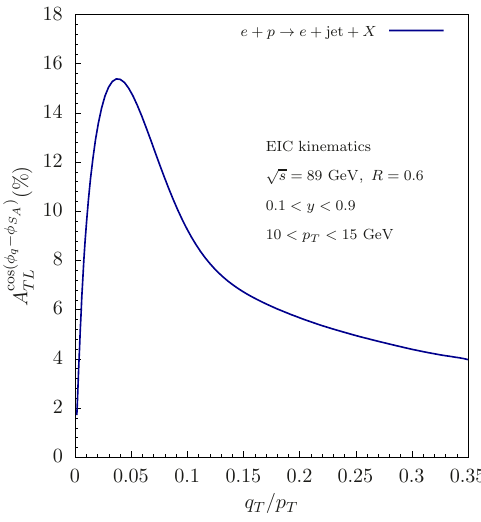
Figure 2 . Spin asymmetry of back-to-back electron-jet production from the collision of transversely polarized proton and longitudinally polarized electron as a function of q T /p T , the ratio between the momentum imbalance q T and the jet transverse momentum p T . Here we apply the center-of-mass √ energy s = 89 GeV of EIC kinematics, jet radius R = 0 . 6 , event inelasticity 0 . 1 < y < 0 . 9 and jet transverse momentum 10 < p T < 15